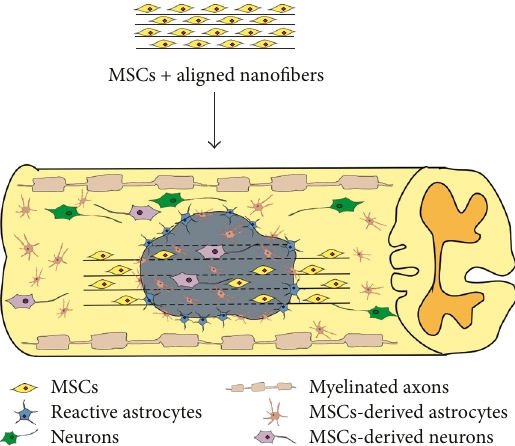
Figure 1: Biomaterials with di ff erent topographies have the capacity of mimicking the ECM of the CNS tissue and further in fl uencing the growth behavior of transplanted stem cells. The aligned nano fi bers were supposed to improve the migration and di ff erentiation of cells after